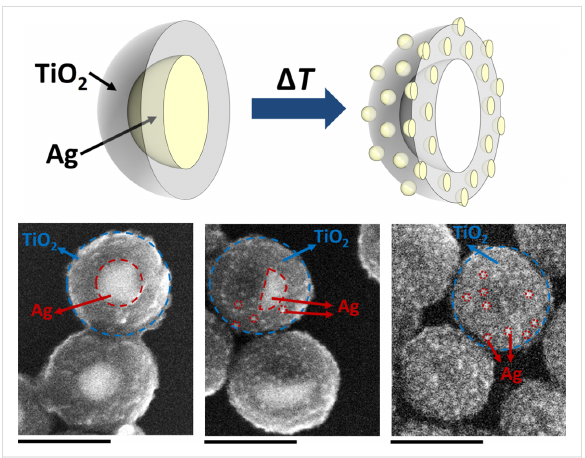
Figure 1: Formation of Ag-modified TiO 2 HSs (top) and SEM images showing Ag–TiO 2 nanostructures at different stages of their fabrication (bottom, scale bar = 200